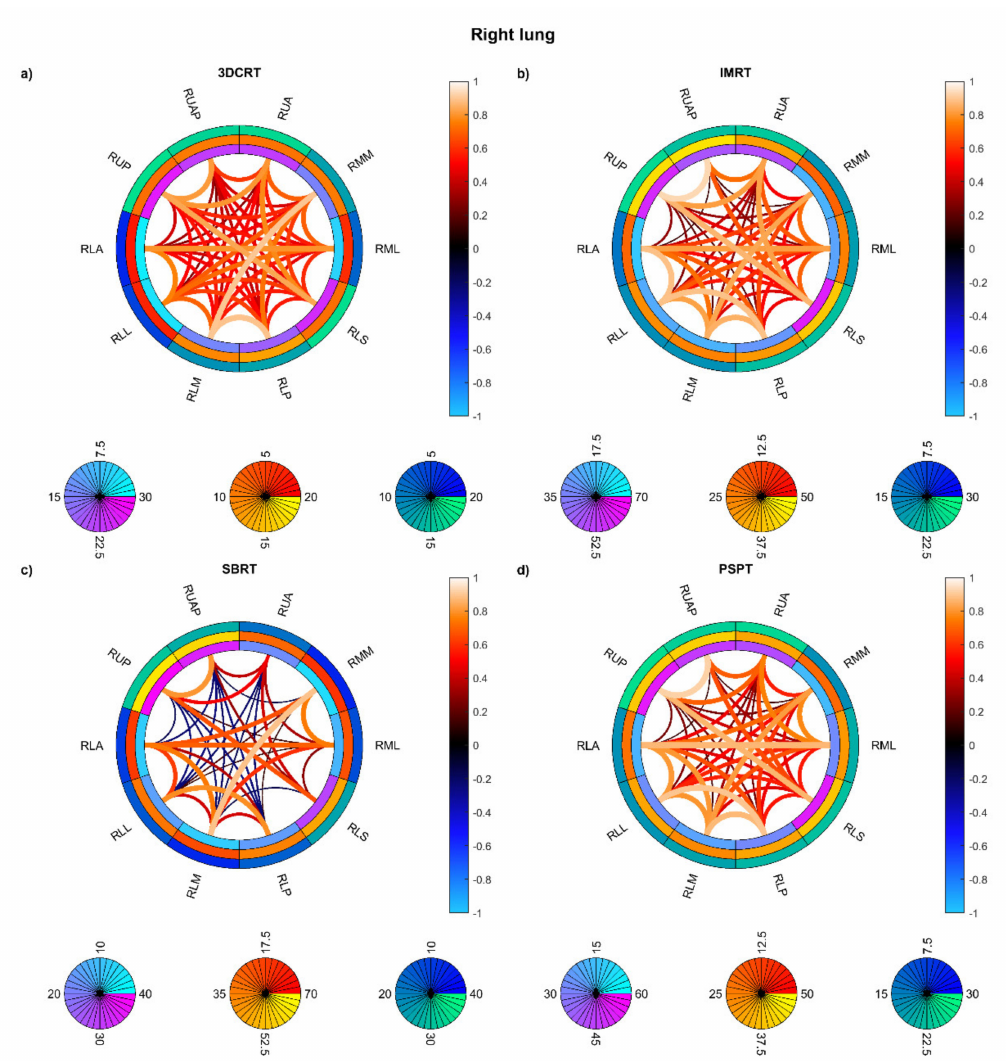
Figure 8. Connectograms in right lung substructures for the four groups of patients: Hodgkin lymphoma group—3DCRT ( a ), non-small cell lung cancer patients treated with intensity-modulated radiation therapy—IMRT ( b ), NSCLC patients treated with stereotactic body RT—SBRT ( c ), NSCLC patients treated with passive-scattering proton therapy—PSPT ( d ). The pairwise Spearman correlation coefficients between the mean biological effective dose (BED) values to the reported substructures are represented by the lines within the rings. From inside to outside, the rings represent the average of the substructure mean BEDs, standard deviation of the substructure mean BEDs, and average of the dose standard deviations within the substructure. BED is expressed in Gy. Abbreviations: RLA: right lung lower lobe anterior; RLL: right lung lower lobe lateral; RLM: right lung lower lobe medial; RLP: right lung lower lobe posterior; RLS: right lung lower lobe superior; RML: right lung middle lobe lateral; RMM: right lung middle lobe medial; RUA: right lung upper lobe anterior; RUAP: right lung upper lobe apical; RUP: right lung upper lobe